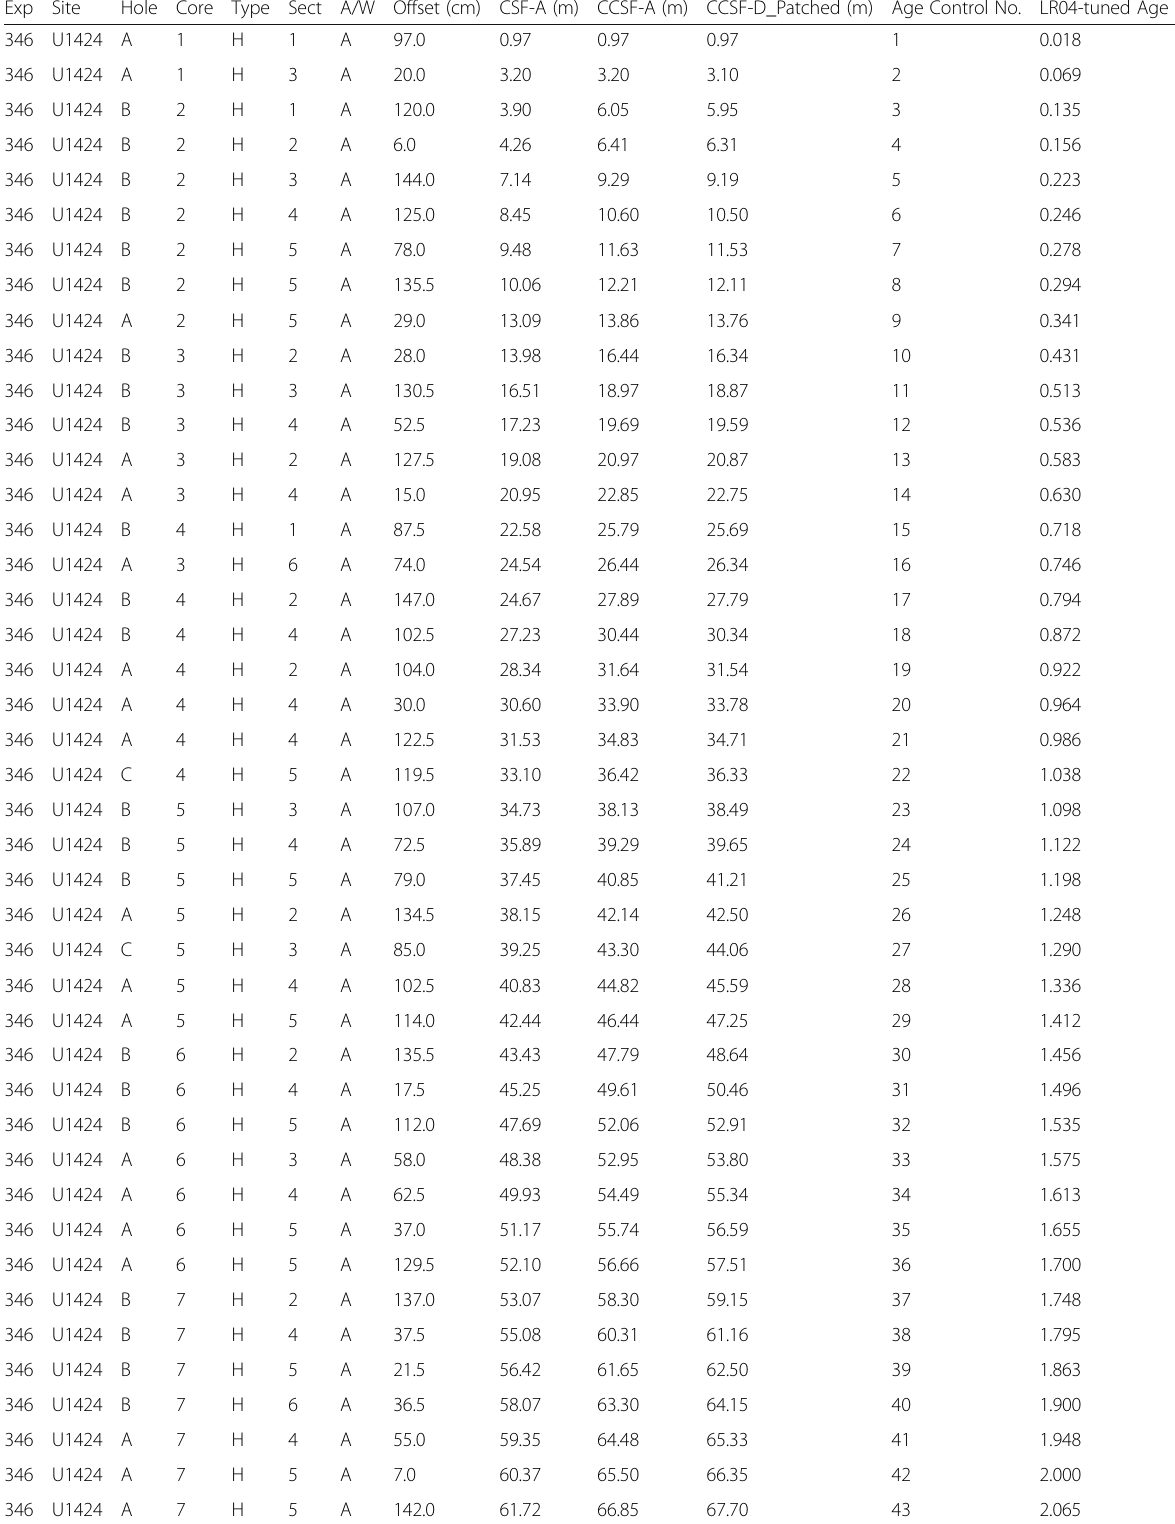
Table 2 A list of correlation point numbers, their depths (CCSFD_patched) on U1424 composite column, and their corresponding ages on LR04 δ 18 O stack profile. Correlation points are also shown in Additional file 2: Figure S2 Exp